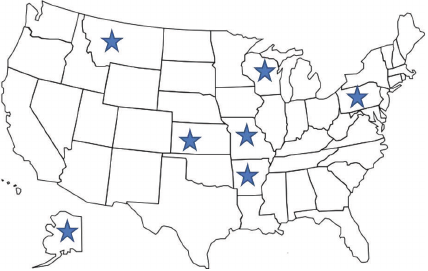
Figure 1: Geographic representation of study